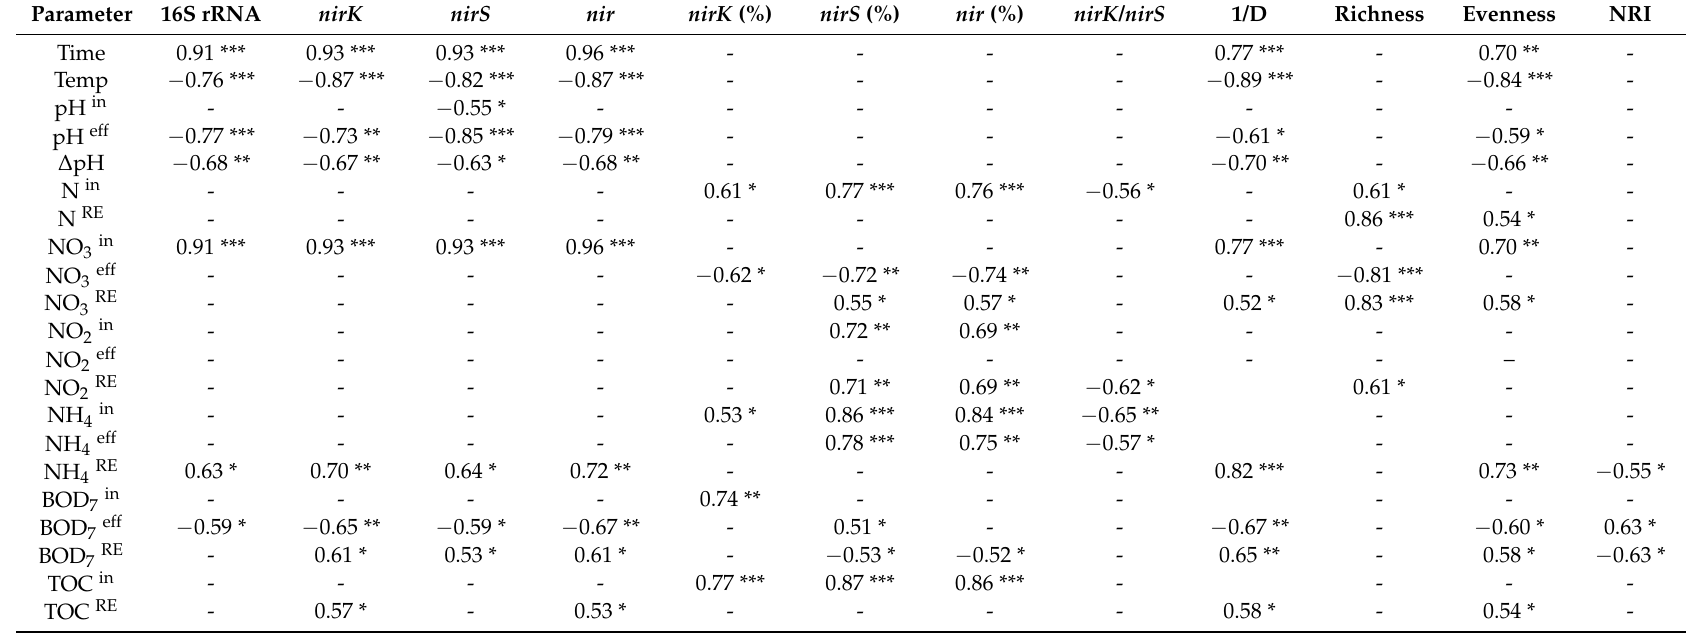
Table A2. Correlation of target gene abundances and characteristics of HSSF MCs. Statistically significant Spearman’s rank correlation coefficient values between target gene characteristics—concentrations: 16S rRNA, nirK, nirS, nir , and proportions: nirK (%), nirS (%), nir (%) and nirK / nirS , values of the Inverse Simpson’s diversity (1/D), richness (refers to the number of operational taxonomic units or OTUs at the 95% similarity level), evenness, Net Relatedness Index (NRI), and indicator parameter values in influent ( in ) and effluent ( eff ), and removal efficiencies ( RE ) of respective compounds during the treatment process in HSSF MCs, as well as system operation time and temperature (Temp) in MCs. ∆ pH indicates pH difference between influent and